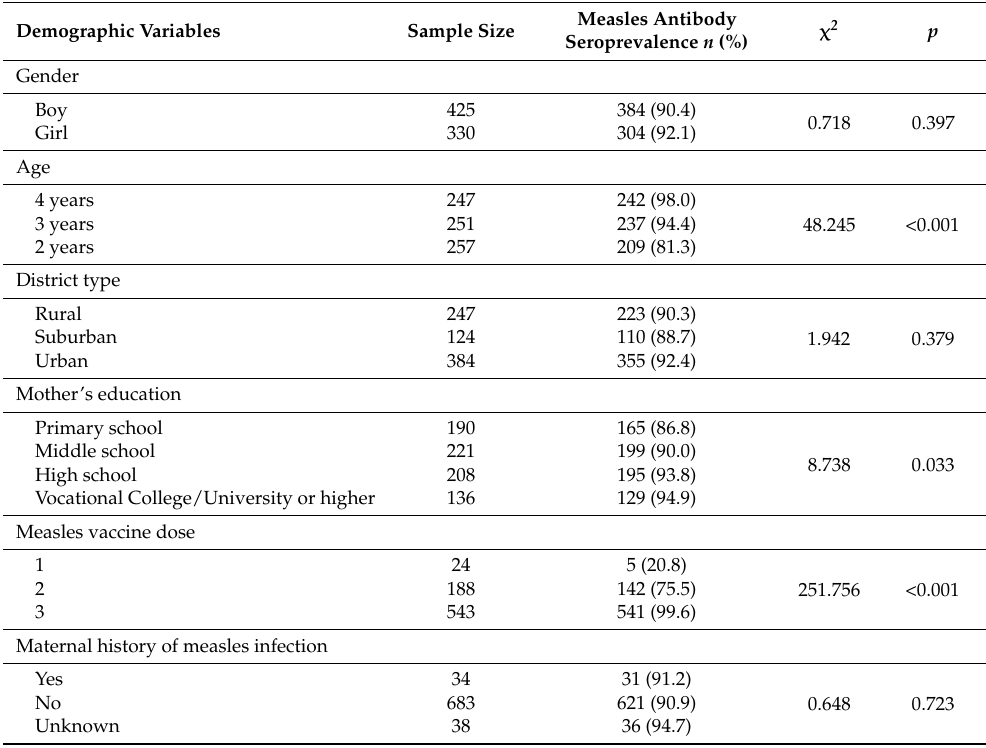
Table 2. Seroprevalence of the antibody to measles in association with demographic variables among 755 healthy children in Qian County, China.